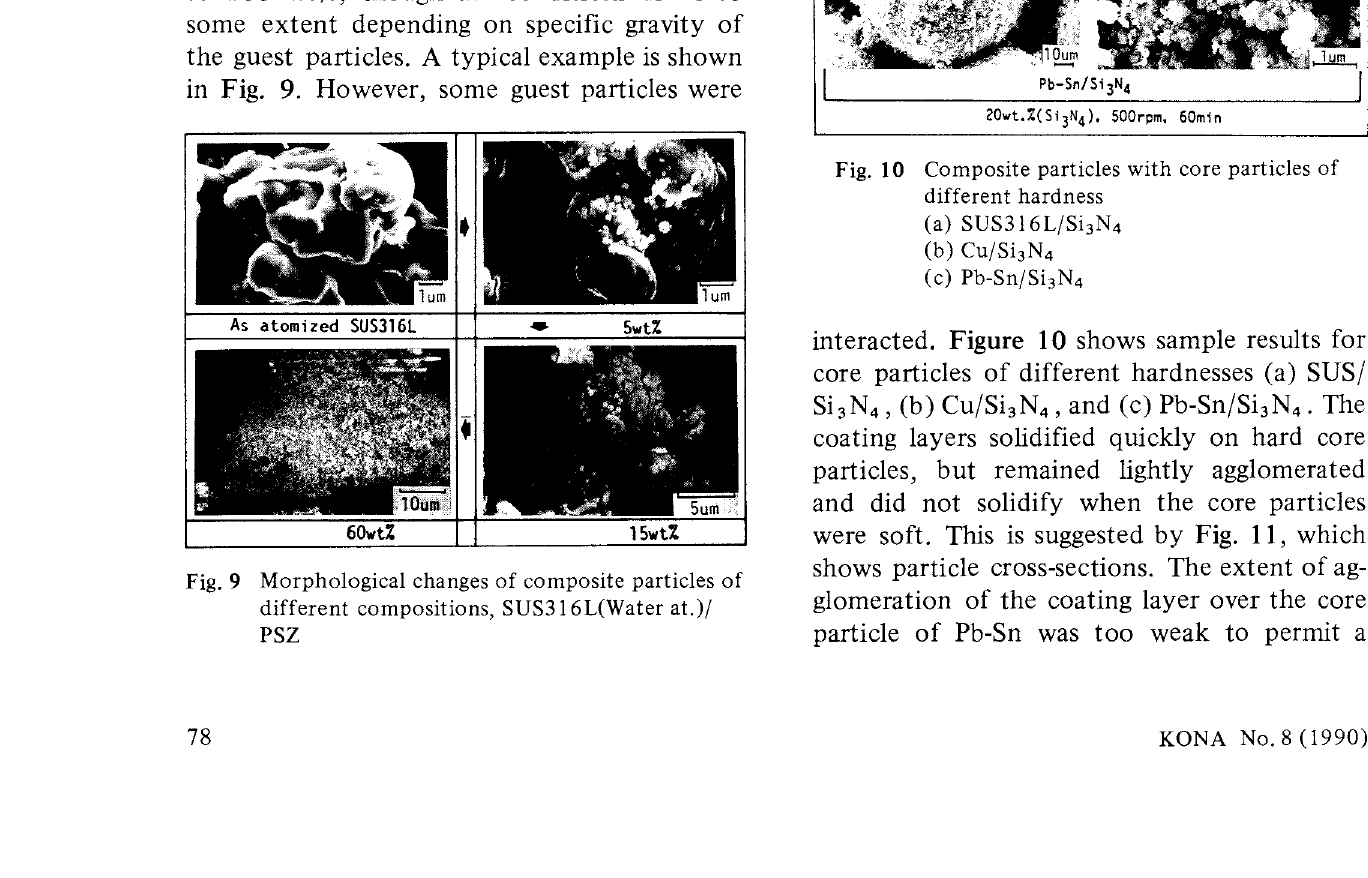
Fig. 8 Morphological changes of the composite particles under a vacuum during cooling, S US316L/PSZ. 1.8 ks